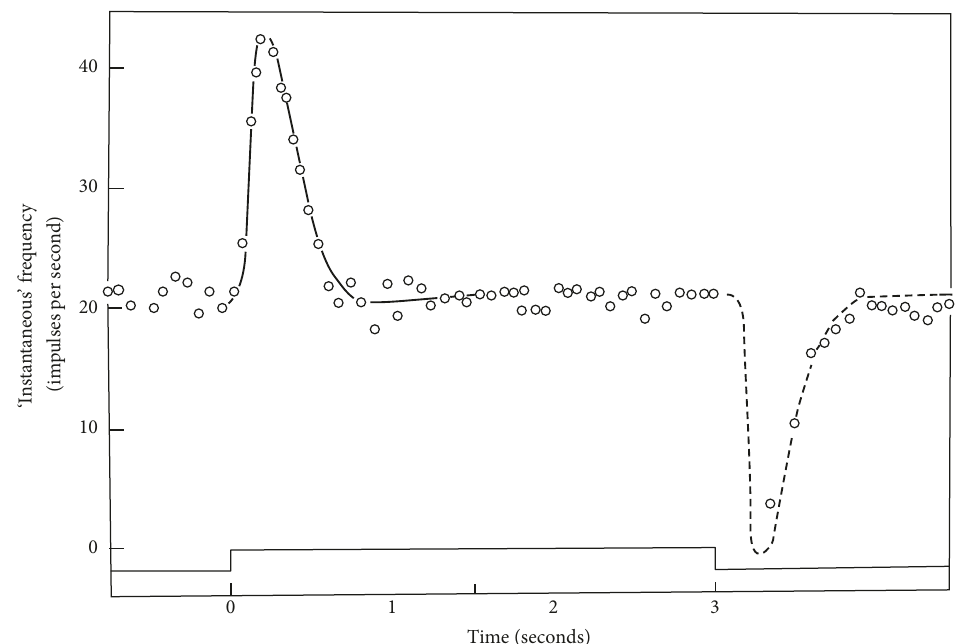
Figure 12: Variation in the rate of firing of a single ommatidium of the eye of a horseshoe crab in response to changing levels of illumination. Reproduced from [93, Figure 16], with permission from the Optical Society of